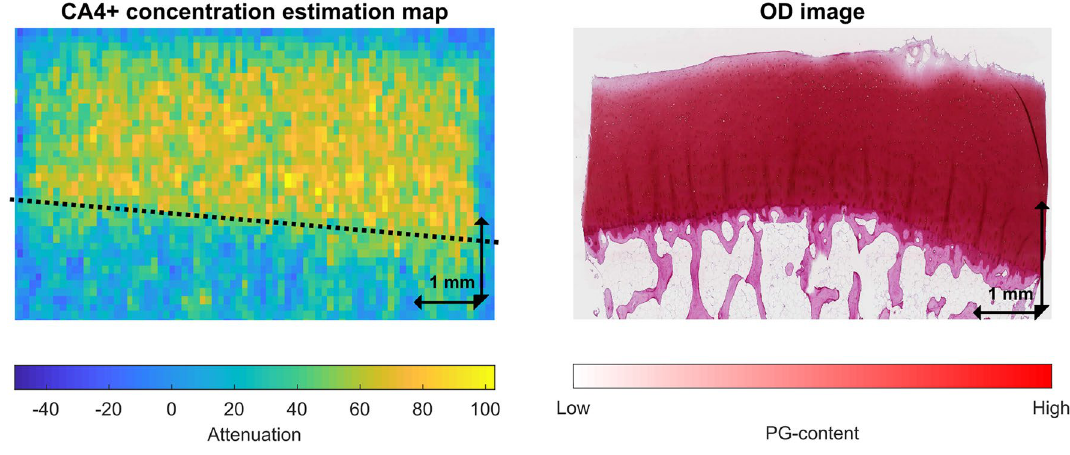
Figure 2. CA4+ concentration map (left) and optical density (OD) image (right) of a single representative sample. The dotted black line indicates roughly where the bone-cartilage borderline is. The articular cartilage surface is at the top part of the image and the subchondral bone can be seen at the bottom.